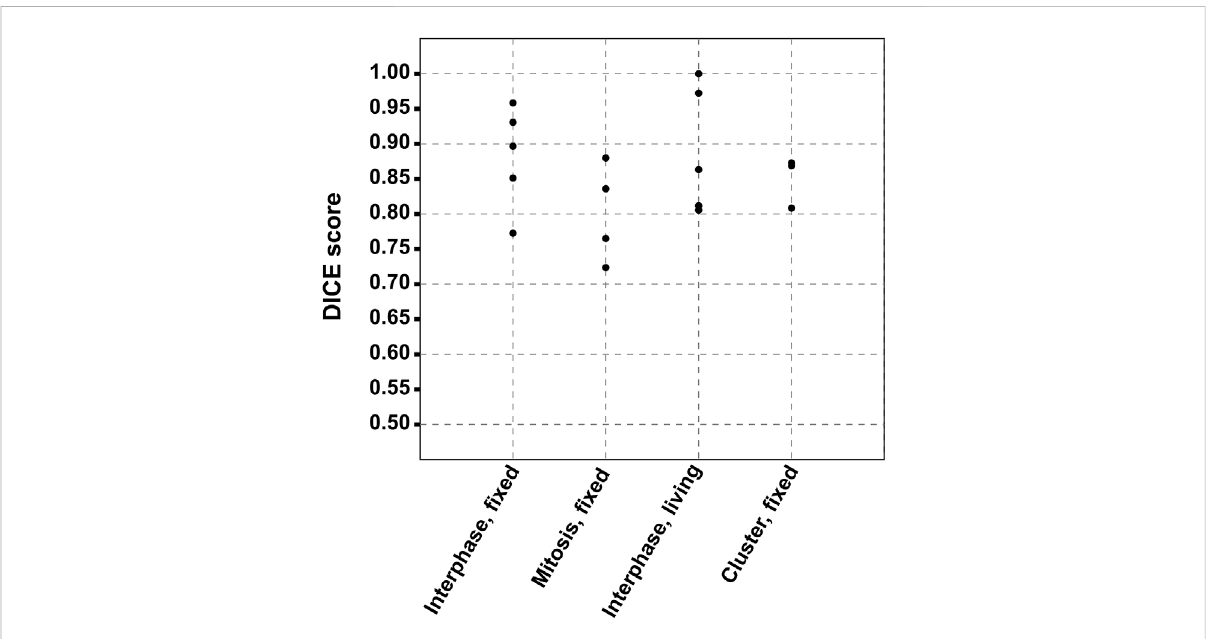
FIGURE 10 Dicecoef fi cientsaccordingtothephysiological state ofthecells.The similarity wascalculatedbetweenthegroundtruth, correspondingtothe manual segmentation from bright- fi eld images and the segmentation mask generated by the MC 2,S method.